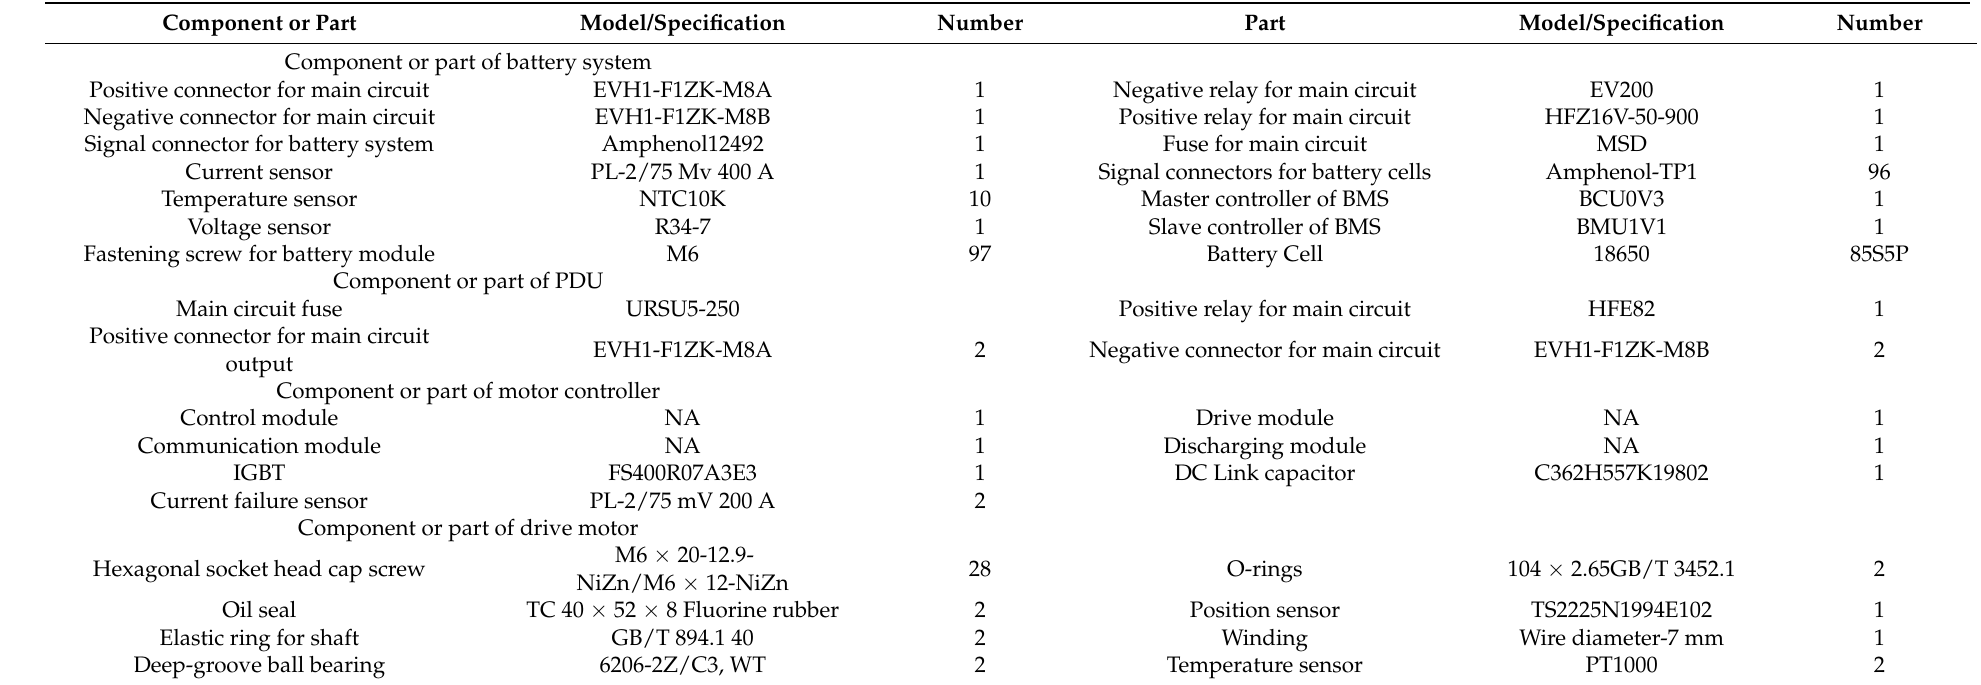
Table A1. Components or parts of subsystems in powertrain system.